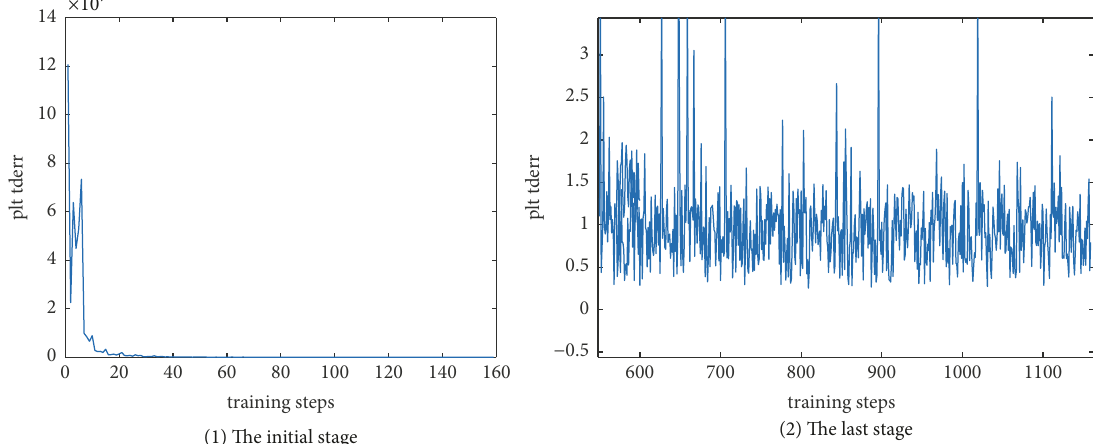
Figure 4: Training curves of the loss function of Q target network. Each point is the average loss function value achieved per ten epochs. The 𝑦 -axis denotes the value of loss function and 𝑥 -axis denotes iteration epoch.